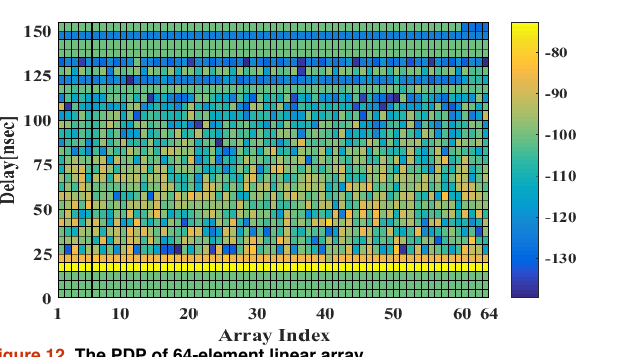
Figure 12. The PDP of 64-element linear